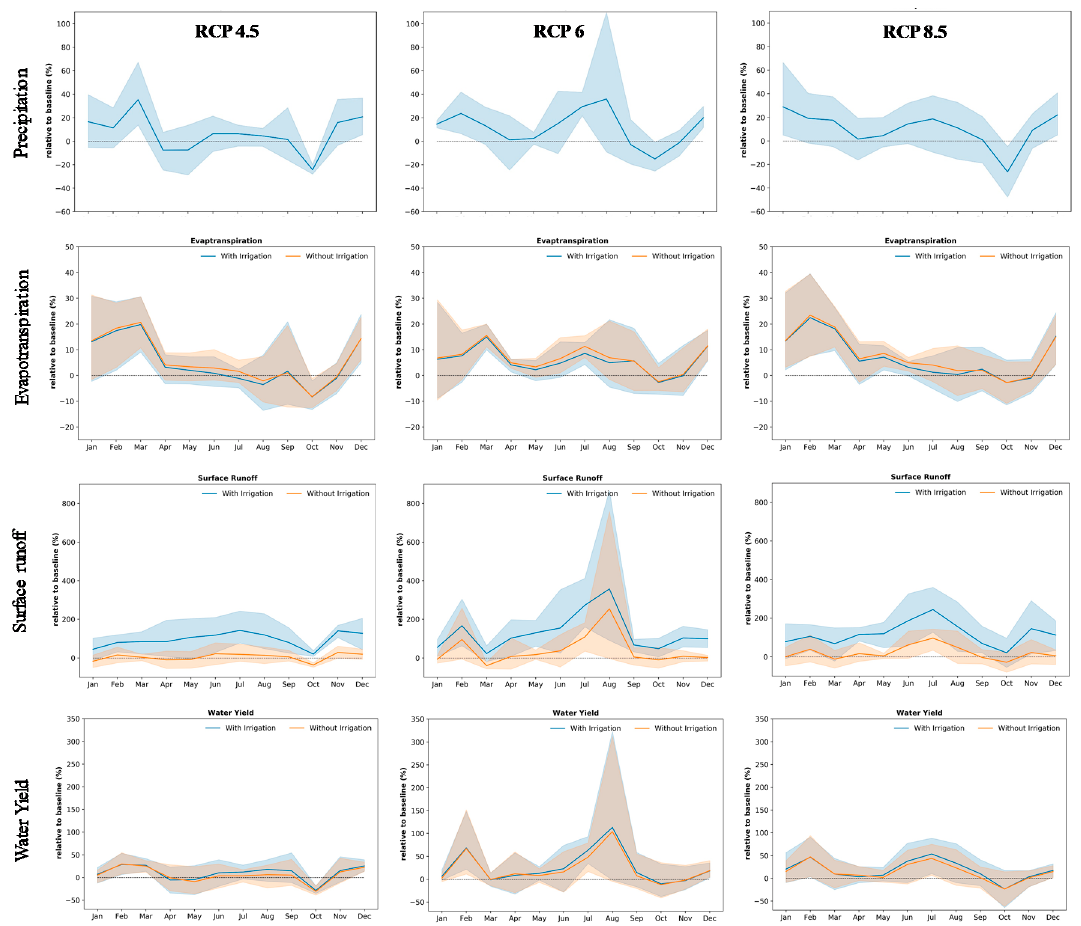
Figure 7. Changes in monthly precipitation, evapotranspiration, surface runoff, and water yield for mid-century (2035–2049) under three scenarios: RCP 4.5, RCP 6, and RCP 8.5. The results are presented as relative the percentage change compared to the baseline period (1986–2000).